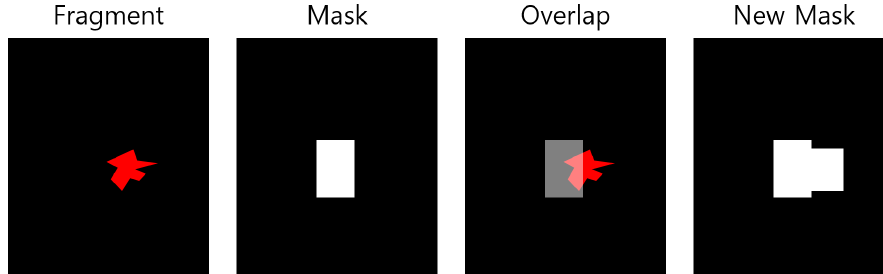
Figure 11. An illustration of a post-processing method for updating a currently generated mask.